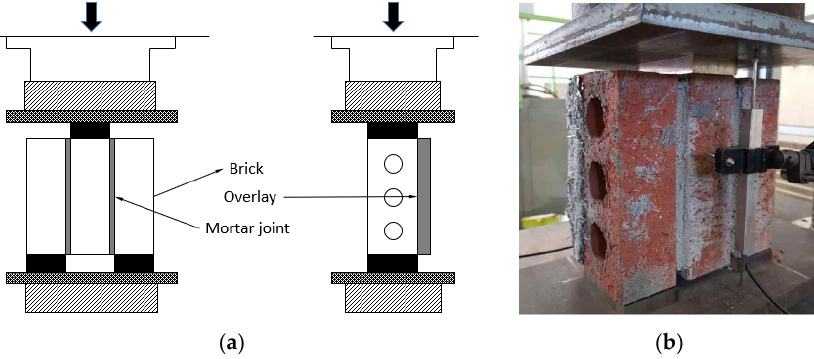
Figure 2. Test setup for determining bond strength between masonry layer and ASFRM overlay: ( a ) Loading scheme; ( b ) Instrumentation.